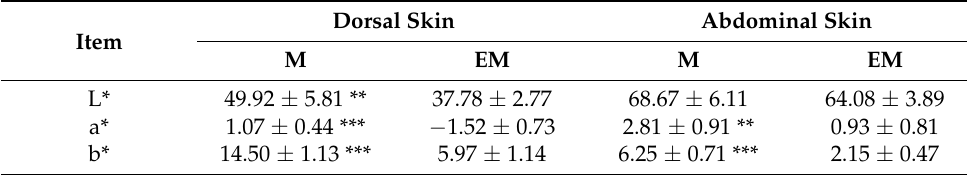
Table 2. Chroma values of largemouth bass skin.